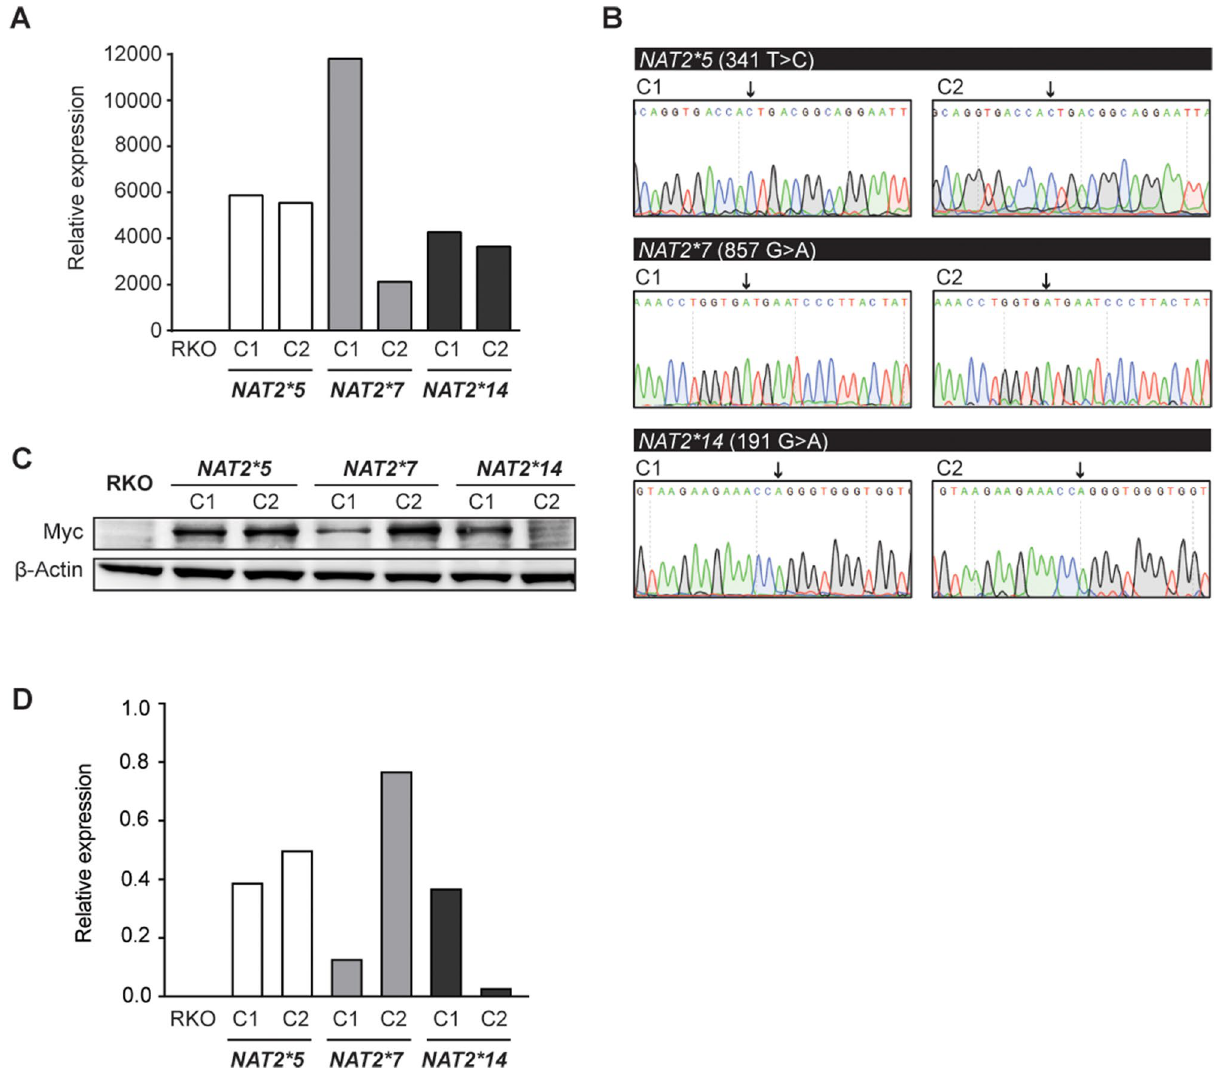
Figure 3. Generation of stable CRC cell clones expressing NAT2 slow acetylator variants. ( A ) Two clones encoding each of the indicated NAT2 slow acetylator variants were chosen for downstream analyses based on their expression of NAT2 RNA relative to parental RKO cells. Data from one representative experiment shown. ( B ) Sanger sequencing revealed the correct 341 T > C, 857 G > A, and 191G > A substitutions in the NAT2 coding region (black arrows) to generate the NAT2*5 , *7 and *14 alleles. ( C ) Protein expression of NAT2 slow acetylator variants by immunoblotting. A Myc-tag antibody was used to detect recombinant NAT2 with β-actin as loading control. Full-length immunoblots are presented in Supplementary Fig. 4. ( D ) Quantification of immunoblots shown in ( C ). Protein expression levels were normalized against